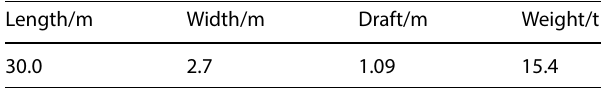
Table 3 Main dimension of full-shaped